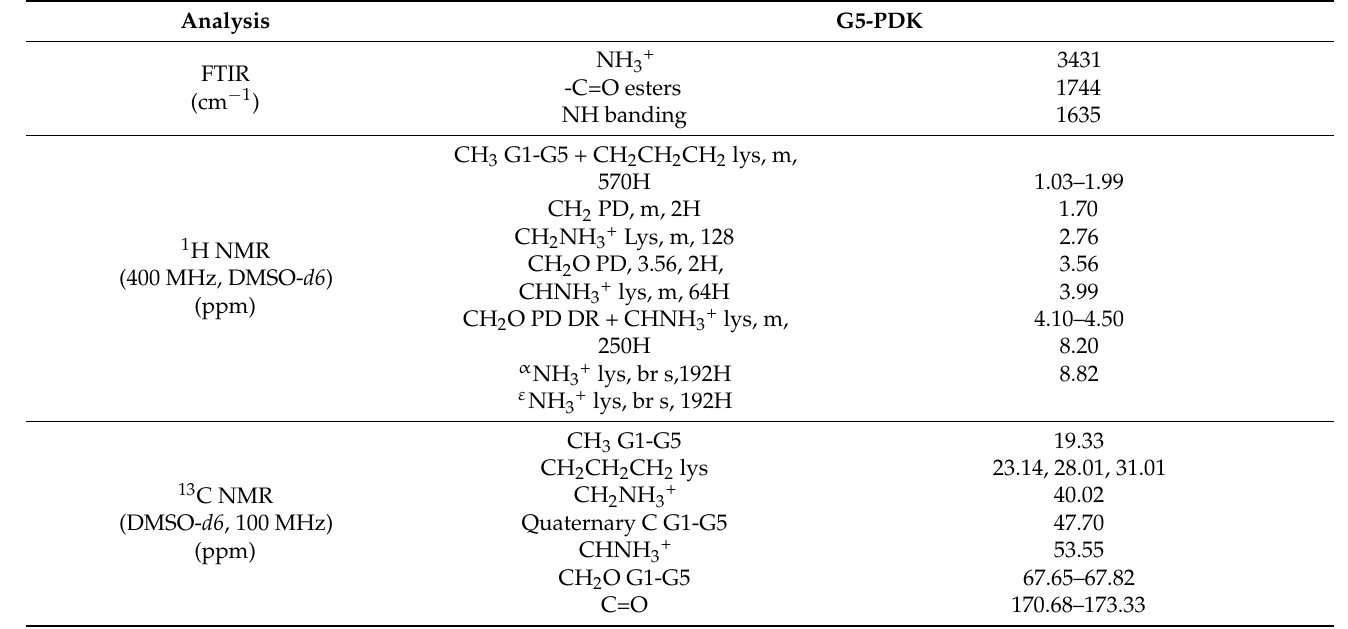
Table 2. Main physicochemical features of